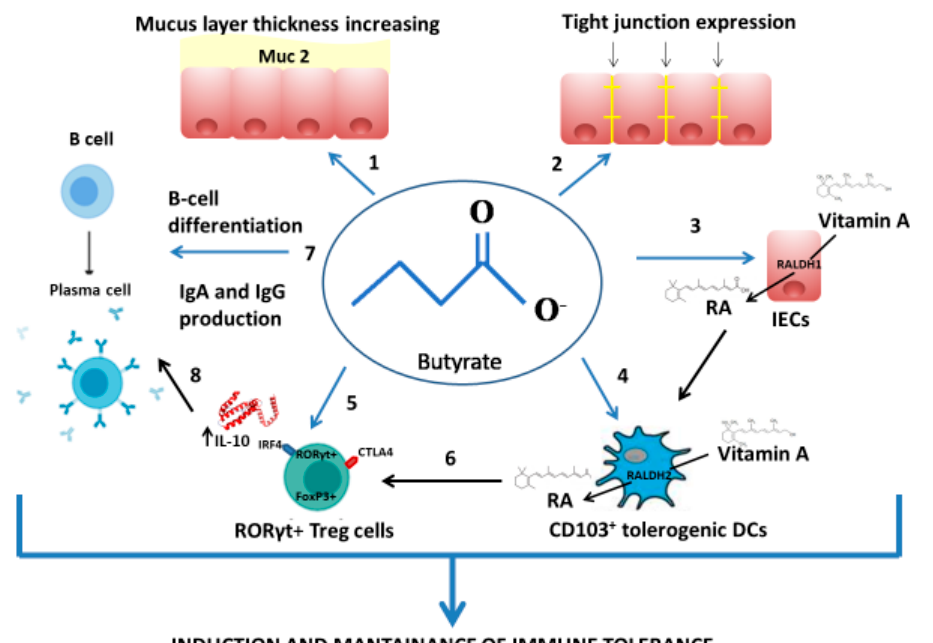
Figure 1. Butyrate exerts immune and nonimmune mechanisms of action against food allergy (FA). Butyrate can improve gut epithelial barrier integrity, increasing mucus layer thickness (enhancing mucin genes’ expression, in particular Muc2) (1) and tight junction expression (2) . Among immune mechanisms, butyrate acts on intestinal epithelial cells (IECs) through two different pathways: (a) the inhibition of histone deacetylases (HDAC) 1 and 3 with subsequent increases in retinaldehyde dehydrogenases (RALDH) 1 activity and retinoic acid (RA) levels (3) ; (b) the interaction with G-protein-coupled receptor (GPR) 43, with subsequent increases in Vitamin A metabolism and epithelial barrier integrity. The effect of butyrate on dendritic cells (DCs) results in increasing RALDH2 activity and RA levels through direct (interaction with GPR109A expressed by DCs) and indirect (RA produced by IECs) mechanisms (4) . Butyrate is also able to induce retinoic acid-related orphan receptor γ t (ROR γ t) + Forkhead box P3 (FoxP3) + T regulatory (Treg) cells thanks to the inhibition of HDAC6 and 9, which leads to increase of FoxP3 gene expression, as well as the production and suppressive function of Treg cells (5). The induction of ROR γ t + FoxP3 + Treg cells is also mediated by DCs interaction (6) . Butyrate may induce B-cell differentiation and IgA and IgG production through HDAC inhibition which leads to acetylation of specific genes involved in B-cell differentiation and/or IgG and IgA production (7) . Moreover, butyrate increases the cellular metabolism necessary for B-cell differentiation and Ig production. These mechanisms are also strongly influenced by IL-10 secreted by Treg cells (8). In the figure, the blue arrows indicate the direct effect of butyrate, the black arrows indicate the indirect effect of butyrate.